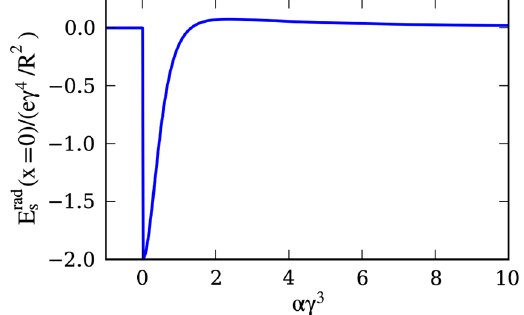
ð x ¼ 0 Þ for a single s